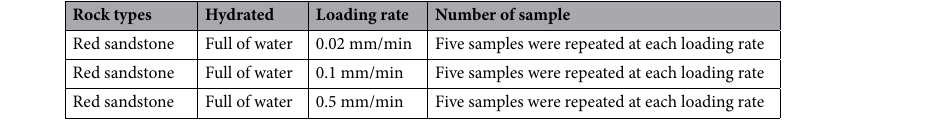
Table 1. Uniaxial-DIC experiments and